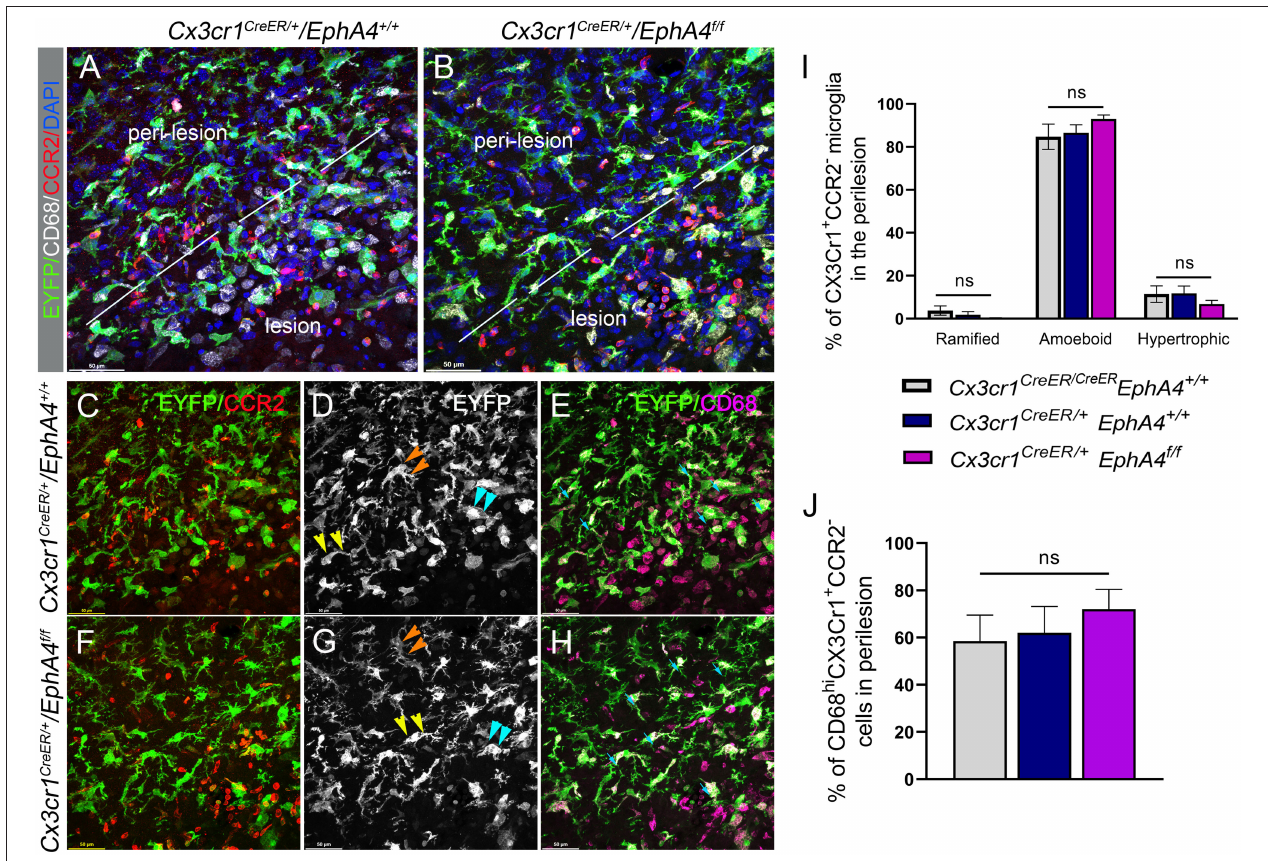
FIGURE 6 | Conditional deletion of microglial EphA4 does not influence microglia activation or ramification, following CCI injury. (A, B) Representative confocal images at max z-projection for immunostaining of CCR2 (red) and CD68 (white) in the cortical lesion and peri-lesion of Cx3cr1 CreER / + EphA4 + / + and Cx3cr1 CreER / + EphA4 f / f mice at 3 dpi. (C, F) Co-localization of CCR2 (red) with Cx3cr1-EYFP (green), showing EYFP + CCR2 − resident microglia in the peri-lesion. (D, G) Microglia ramification in the peri-lesion. EYFP + CCR2 − microglia are either ramified (orange arrowhead), hypertrophic (yellow arrowhead), or amoeboid (cyan arrowhead). (E, H) Representative confocal images, showing CD68 expression (purple) in activated microglia (CD68 + /Cx3cr1 + /CCR2 − , cyan arrow). (I) Quantification of the percentage of resting ramified, activated hypertrophic and activated amoeboid microglia (Cx3cr1 + /CCR2 − ) in the peri-lesion. (J) Quantification of the percentage of CD68 hi microglia (CD68 hi /Cx3cr1 + /CCR2 − ) in the peri-lesion. N = 4–5; ns, nonsignificant difference was observed between different groups.